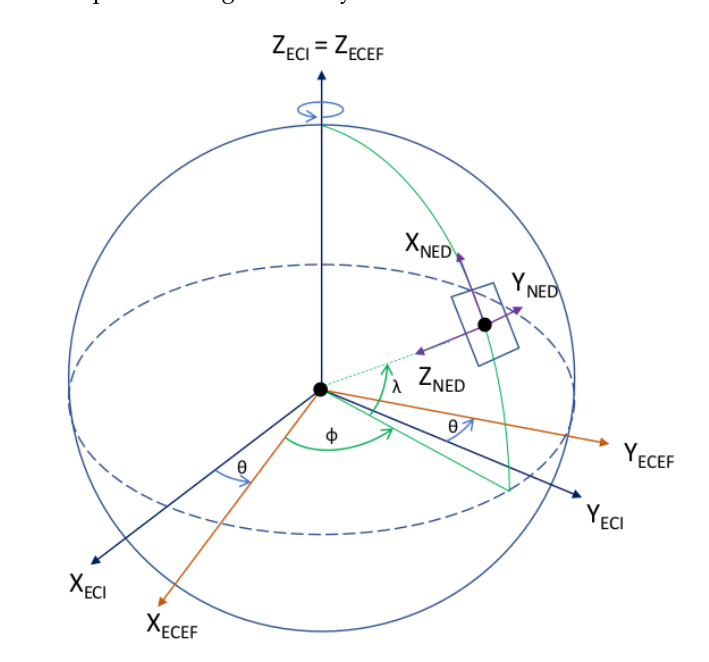
Figure 3. Earth-centered inertial (ECI), Earth-centered Earth-fixed (ECEF), and North East Down (NED) reference